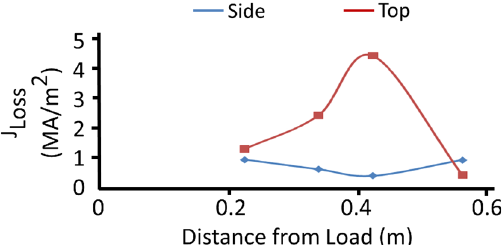
FIG. 3. The measured and simulated current transport effi- =I ciency I is shown as a function of the load impedance Load In ¼ normalized by the minimum vacuum wave impedance Z o 7 . 6 Ω of the MITE MITL at the input to the convolute. The ¼ 0 . 63 . The best fit to the =Z matched load is at 4 . 8 Ω for Z o Load data is shown as the bold red line. The black circle shows the expected value for the worst-case assumption that all the FIG. 4. Time-averaged, loss-current density as a function of electron flow is lost before the load. Solutions for the collisional distance from the load inferred from the TLD measurements for case are limited to lower impedance 1.8 MeV electrons in a 35 ns pulse with a 4 . 8 Ω